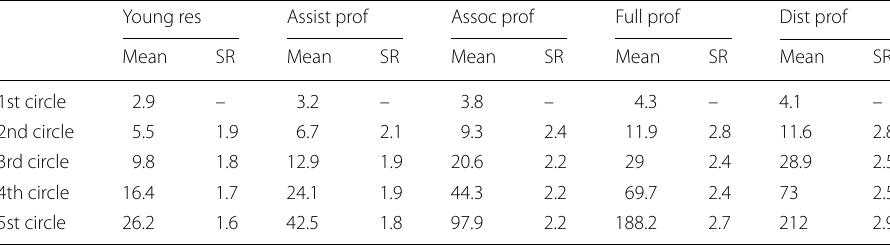
Table 5 Ego network circles at different career stages: mean size and scaling ratio Young res Assist